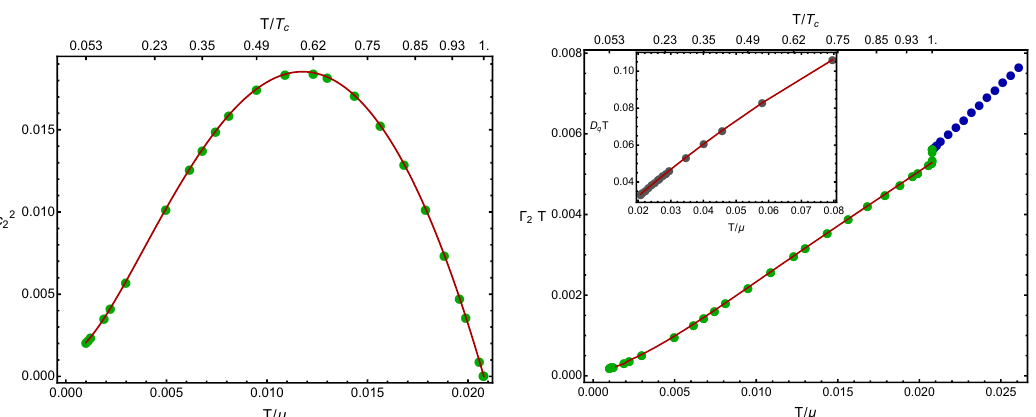
Figure 3 . The propagation speed and the attenuation constant of second sound as function of T/T c above and below the critical point. The red lines are the hydrodynamic formulas (2.3), (2.4) and the colored circles the numerical data extracted from the QNMs. Blue color indicates the normal phase. The inset in the right panel shows the diffusion constant of the purely diffusive mode in the normal phase together with its hydrodynamic